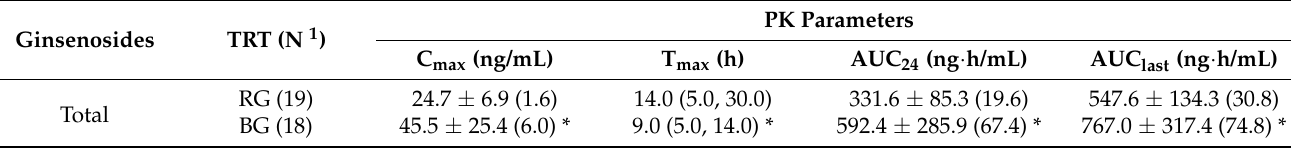
of black ginseng (BG) and red ginseng